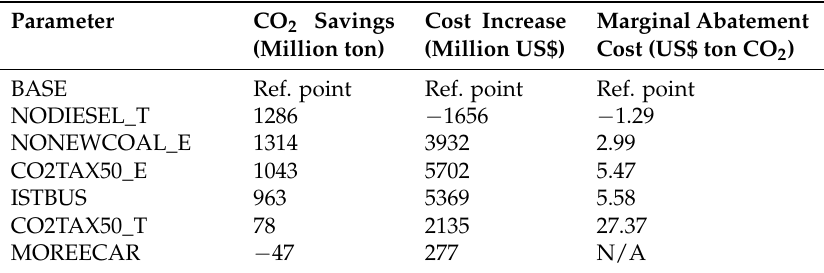
Table 10. Lifetime Marginal Abatement Costs (cost increase/emission savings).